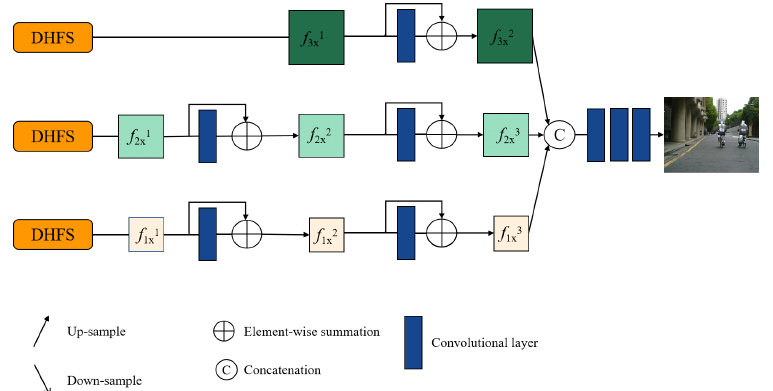
Figure 10. Ablation study for the decoder without